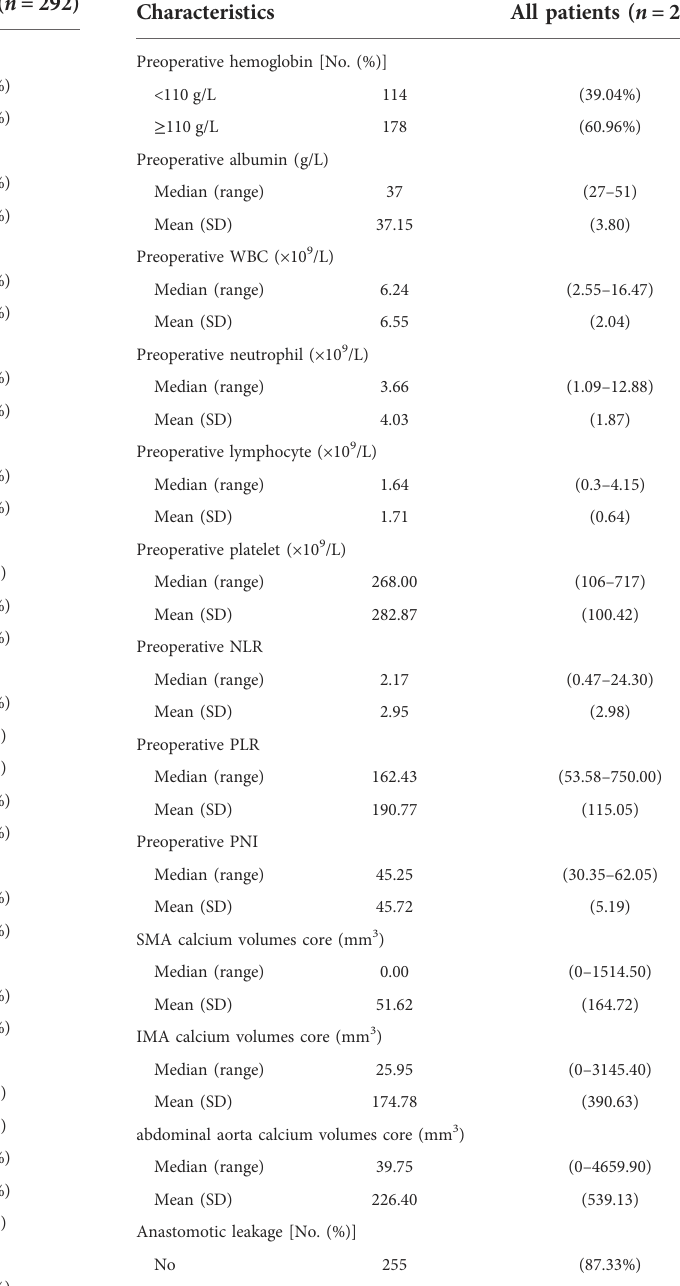
Note: WBC, white blood cell; NLR, neutrophil-lymphocyte ratio; PLR, platelet- lymphocyte ratio; PNI, prognostic nutritional index; SMA, superior mesenteric artery; IMA, inferior mesenteric artery; SD, standard